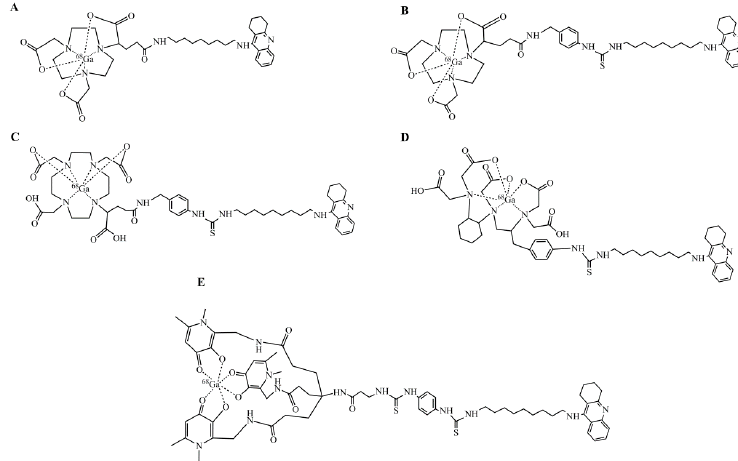
Figure 1. Chemical structures of the developed and investigated radioconjugates: ( A )—[ 68 Ga]Ga-NODAGA-NH(CH 2 ) 9 Tac, ( B )—[ 68 Ga]Ga-NODAGA-Bn-NH(CH 2 ) 9 Tac, ( C )—[ 68 Ga]Ga-DOTAGA-Bn-